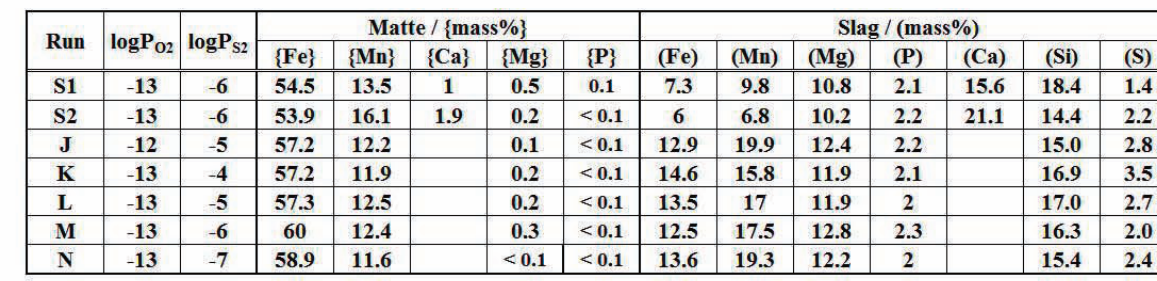
Table 2. Experimental results for series 1.